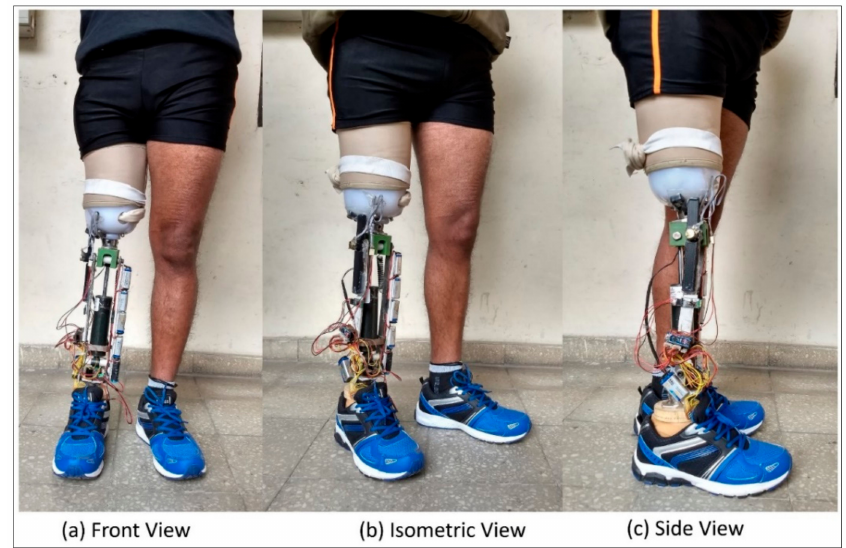
Figure 9. Photograph of experimental setup and subject during testing of prosthesis.